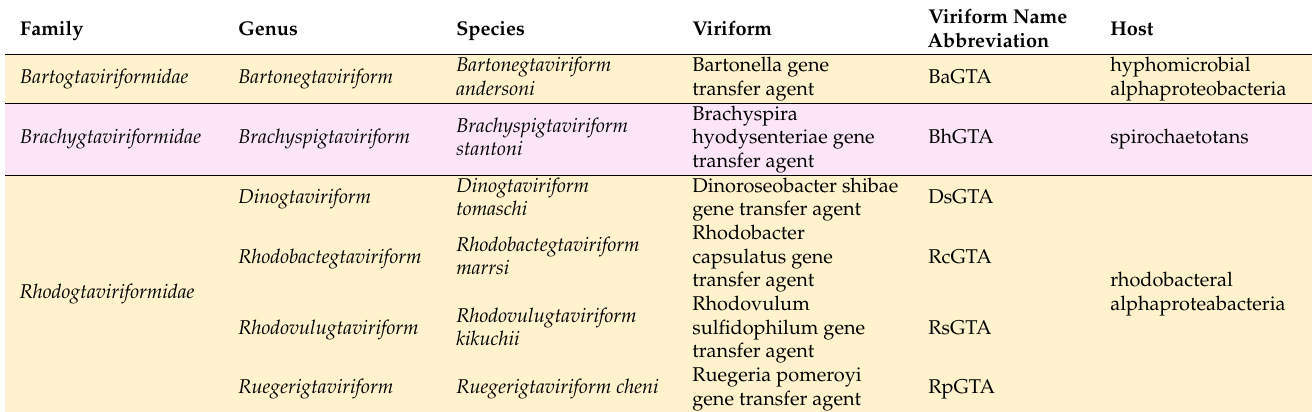
Table 2. 2023 proposed taxonomy of gene transfer agents (GTAs)